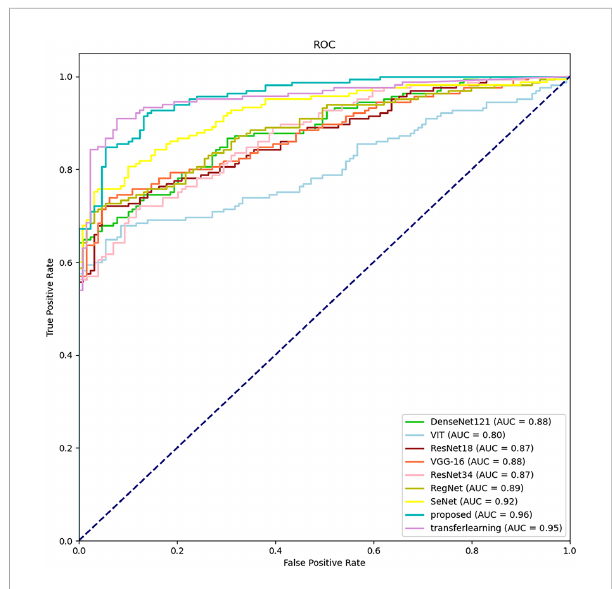
FIGURE 4 Receiver operating characteristic (ROC) curves of correlation networks in test